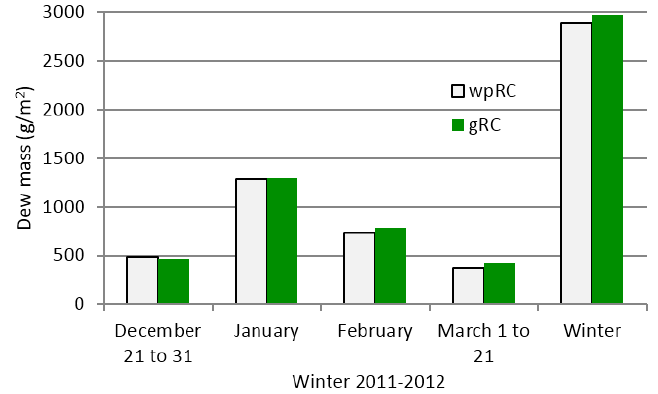
Figure 8. Comparison of the dew harvest in the gRC and wpRC.